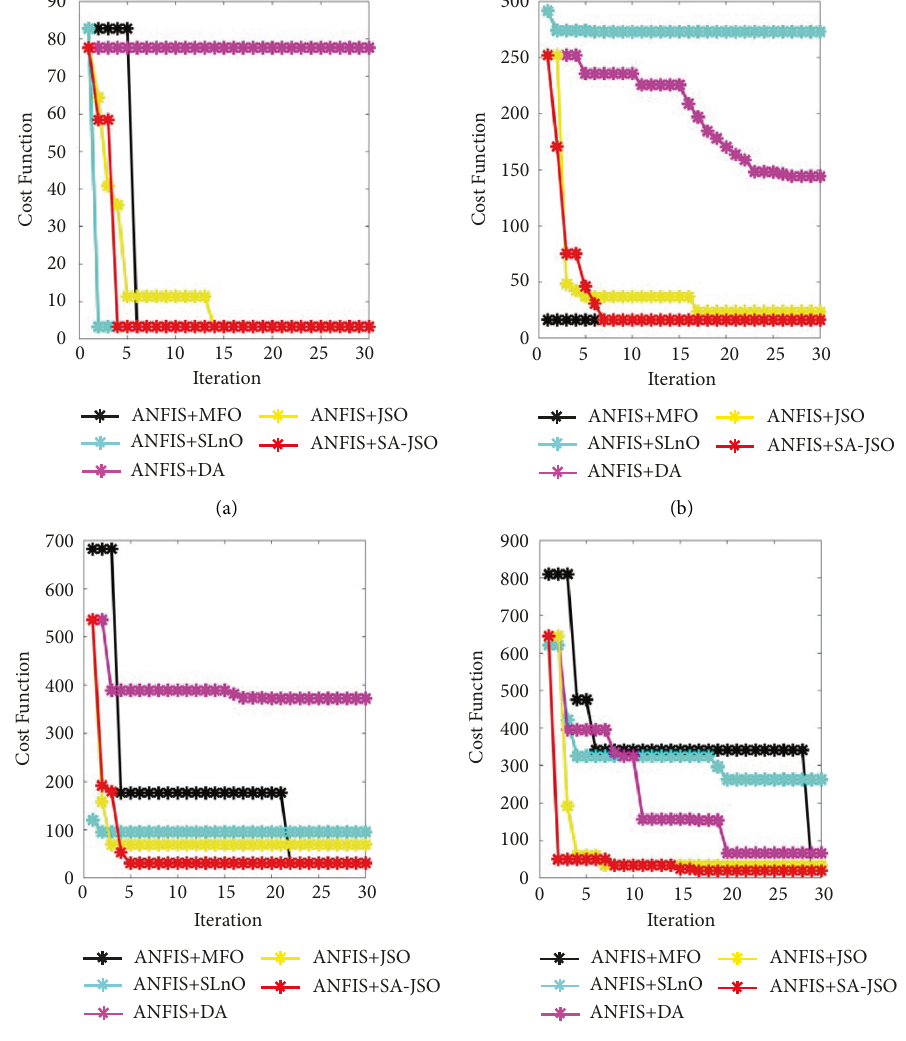
Figure 6: Convergence analysis of developed approach over compared approaches regarding group 2 scenario by fixing counts of nodes as (a) 100, (b) 250 (c) 750, and (d)